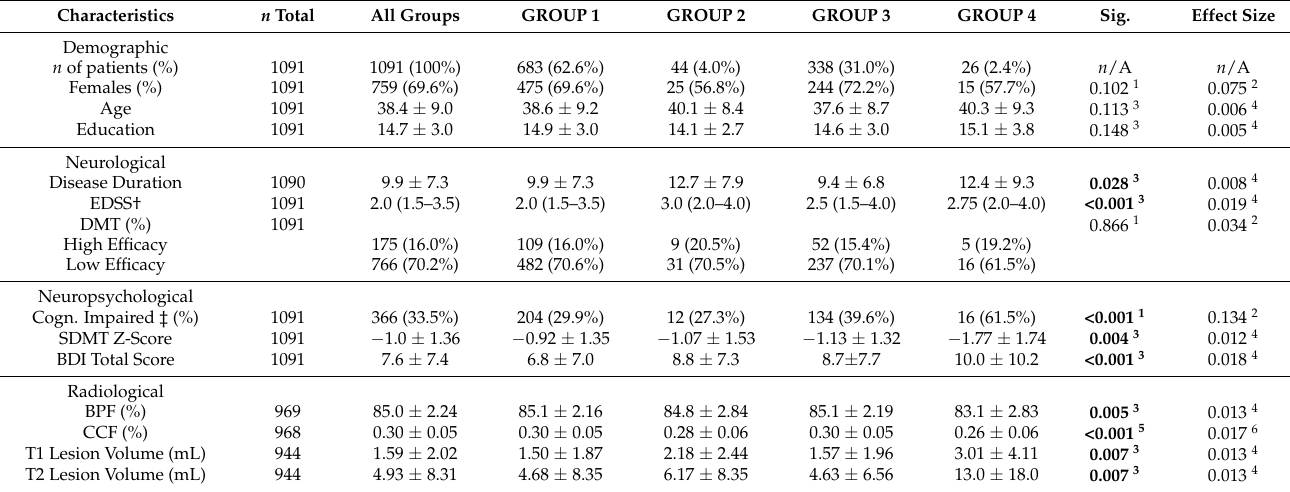
Table 1. Basic sample characteristics at baseline.